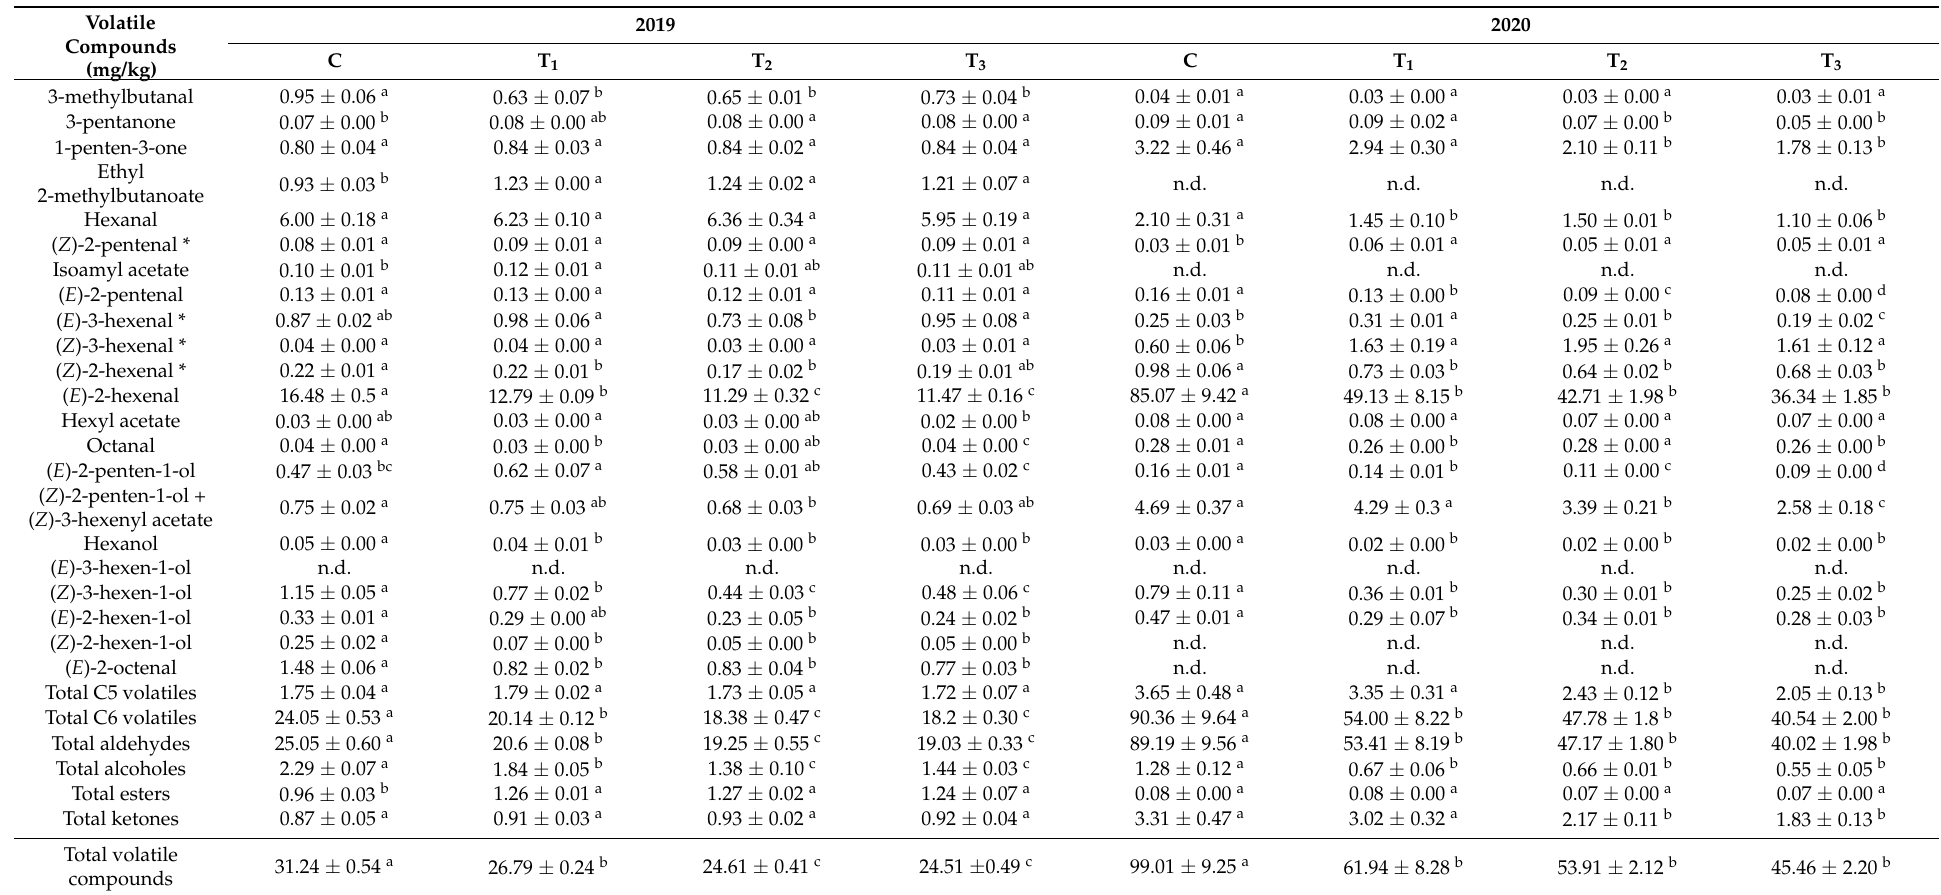
Table 6. Volatile compounds concentration of virgin olive oils from Coratina cv. olive trees grown under different watering regimes during two crop seasons (2019 and